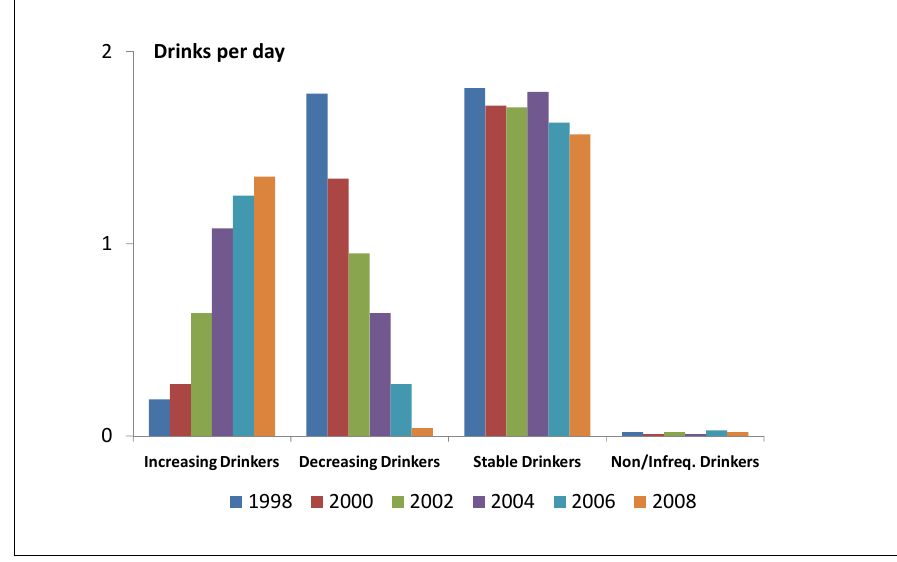
Figure 2. Numbers of drinks per drinking day by trajectory group and year among 4,439